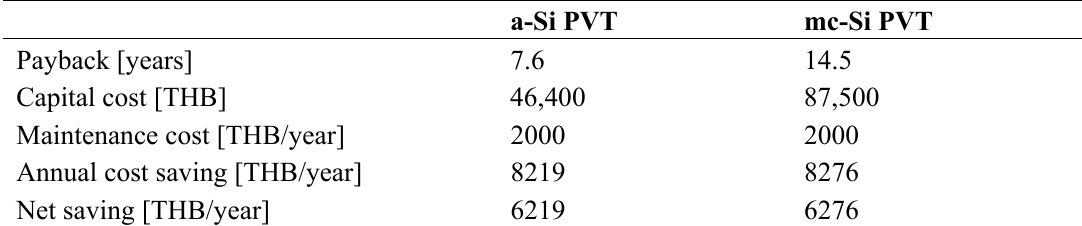
Table 3. Payback of PVT systems in